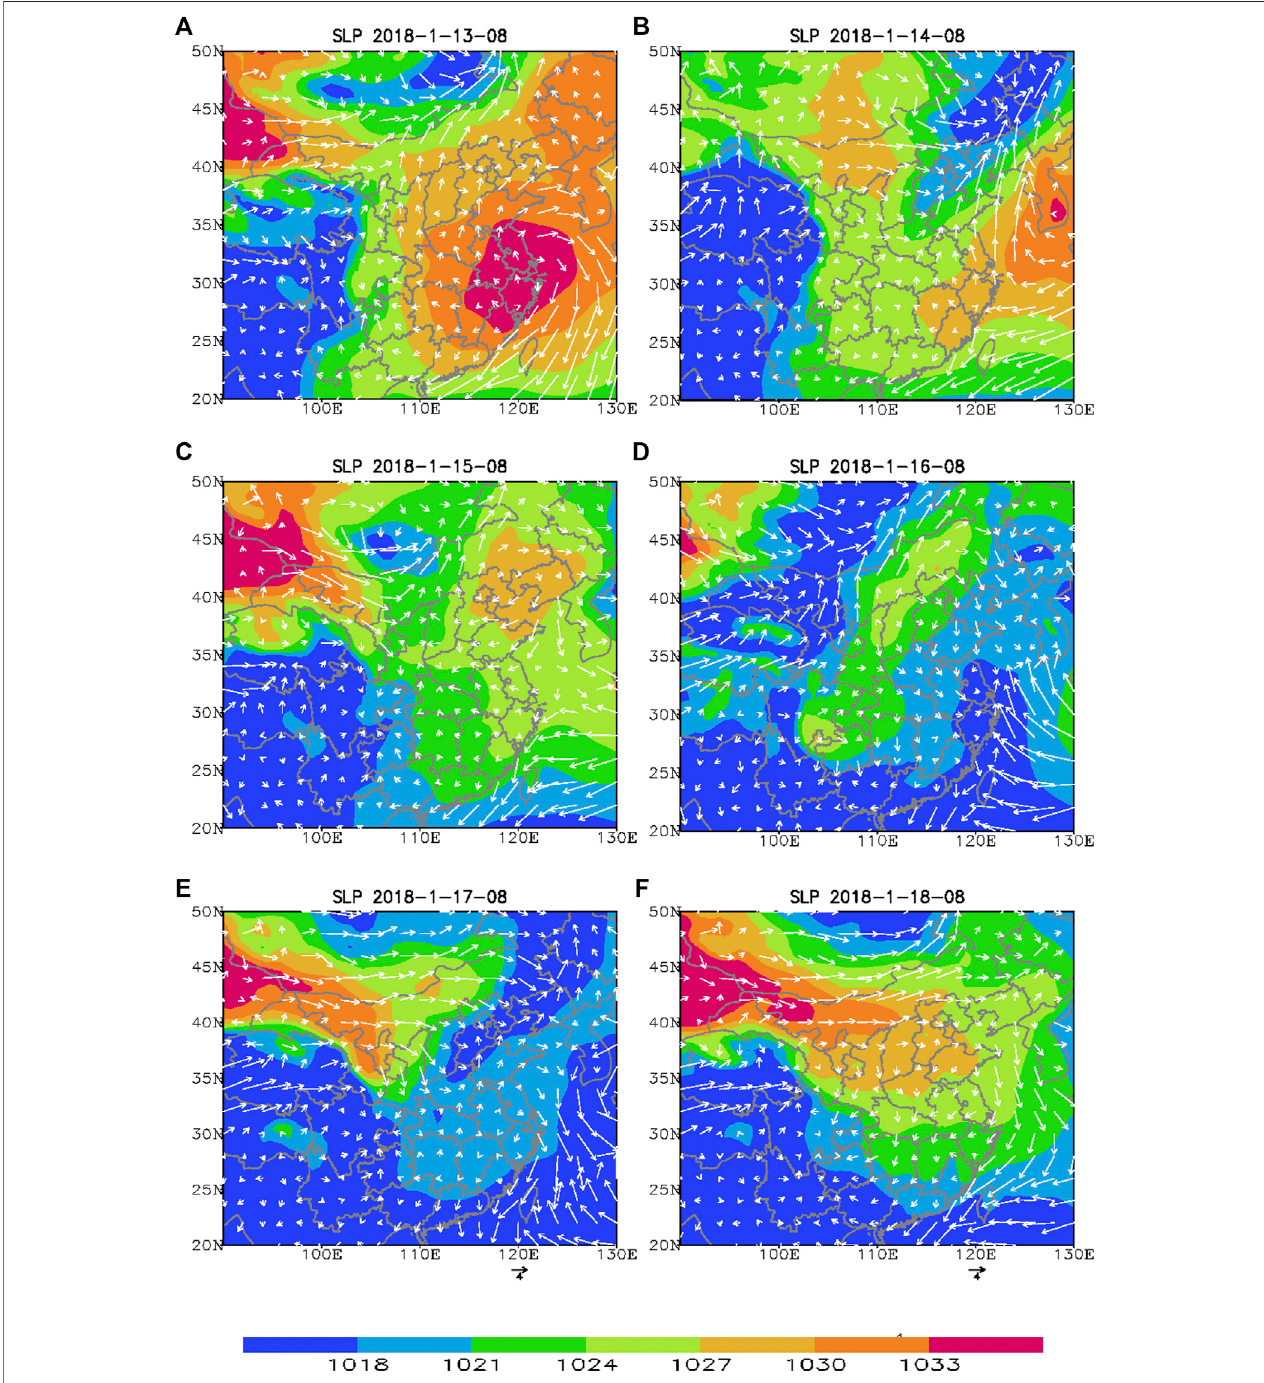
FIGURE5| Distributionsofthesealevelpressure(unit:hPa)and10 mwinds(unit:m/s)at08:00onJanuary13 – 18,2018.Thearrowlengthrepresentswindspeed with 4 m/s. Wind speed 4 m/s.